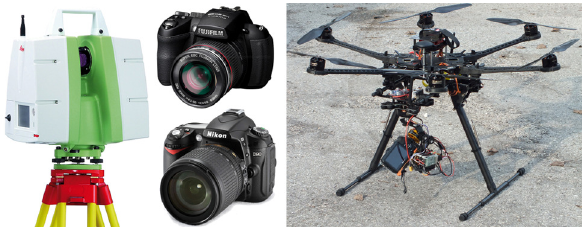
Figure 3. Pictures of the survey equipment. Figure 4. Layout of vegetation and relative shadowing and